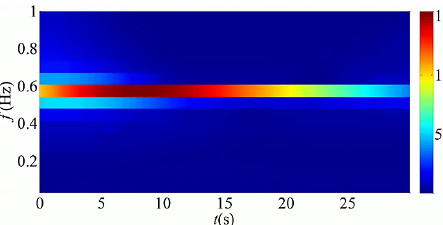
Y-axisa) Figure 11. Cross-correlation functions on different floors along Figure 12. Wavelet time-frequency diagram